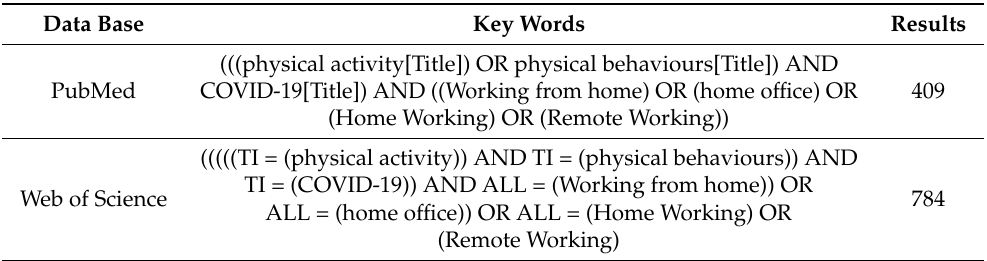
Table 1. Search strategy and identified